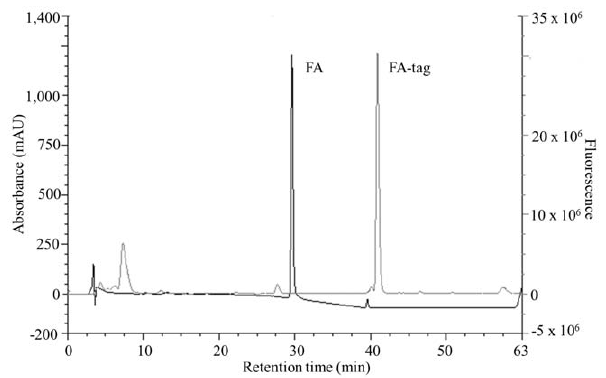
Figure 1. FA HPLC-FD chromatograms. FA (100 pmol) samples before and after derivatization are superimposed. FA (black line) and FA derivatized with AABD-SH (FA-tag, grey line). Left Y axes: UV absorbance, right Y axes: fluorescence.